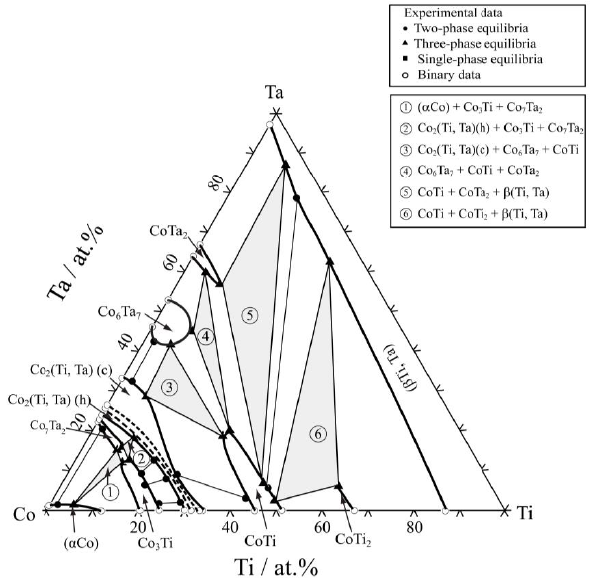
Figure 5. Experimentally determined isothermal sections of the Co-Ti-Ta system at 950 °C by Xu [7].